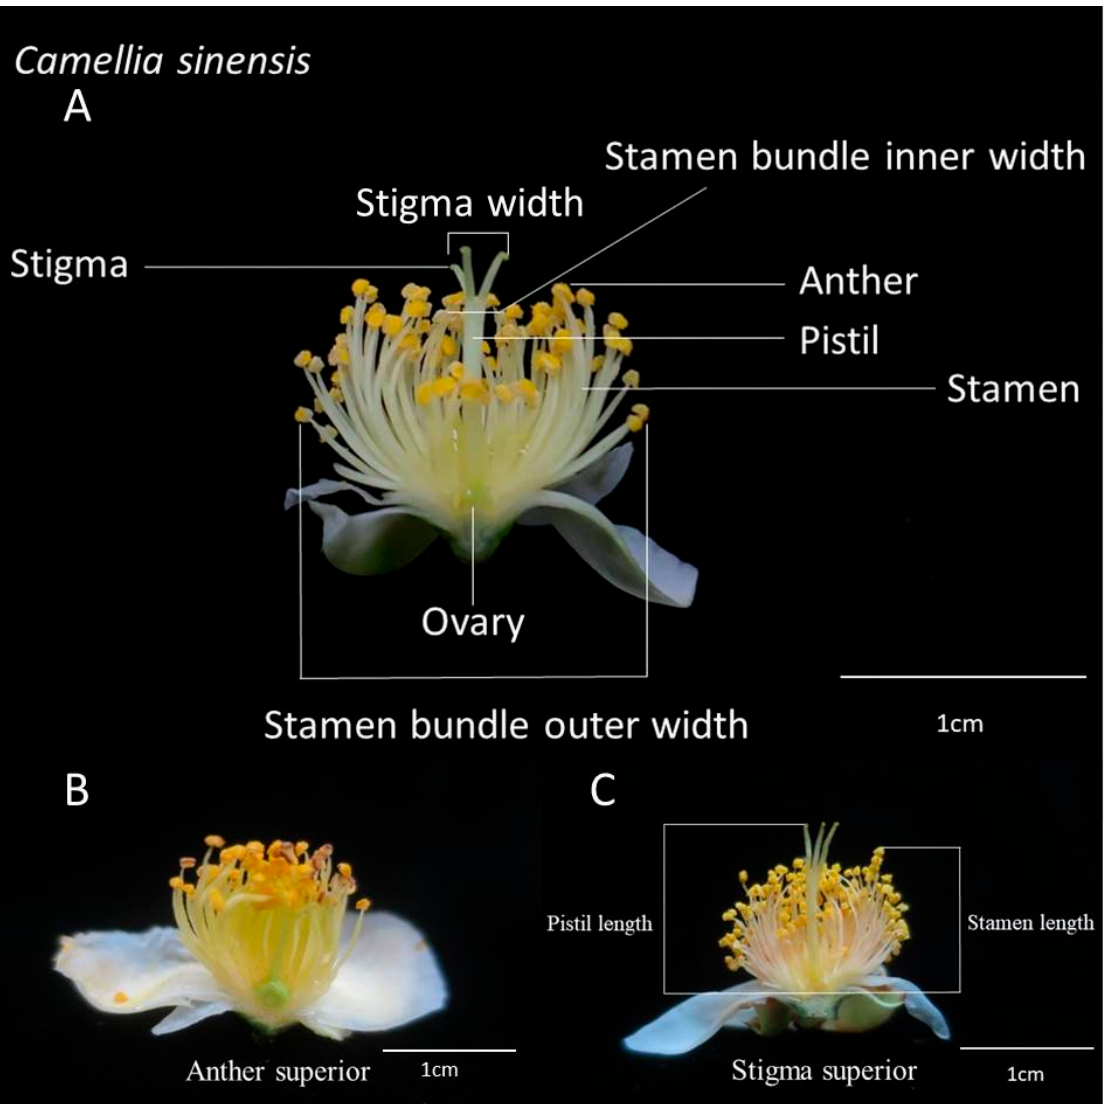
Figure 1. Morphological diagram of the tea ( C. sinensis ) plant’s floral apparatus. ( A ) The measured flower organ; ( B ) the anther superior morphology; and ( C ) the stigma superior morphology. The positions for measurement of pistil length and stamen length are shown.